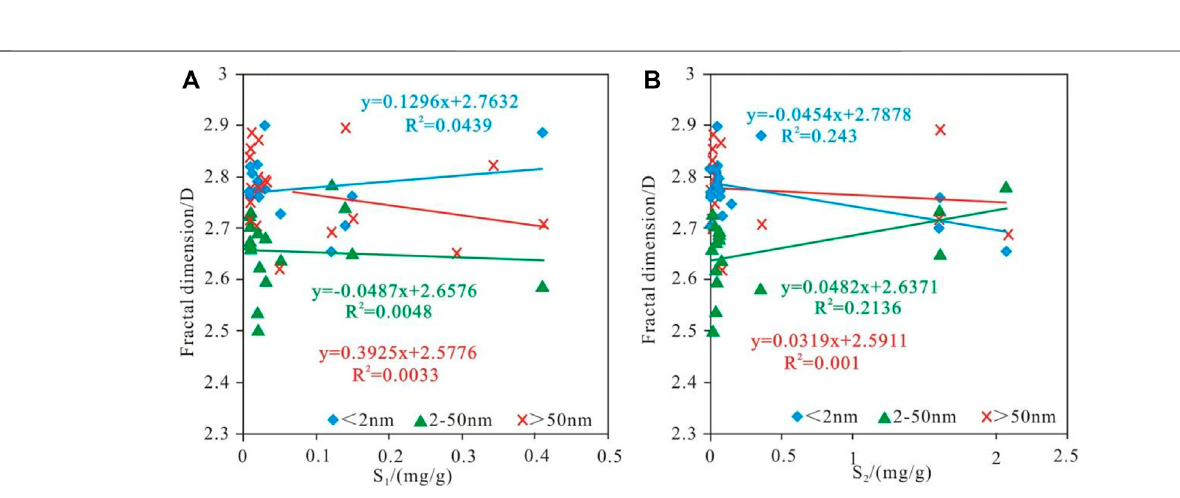
Frontiers in Earth Science |